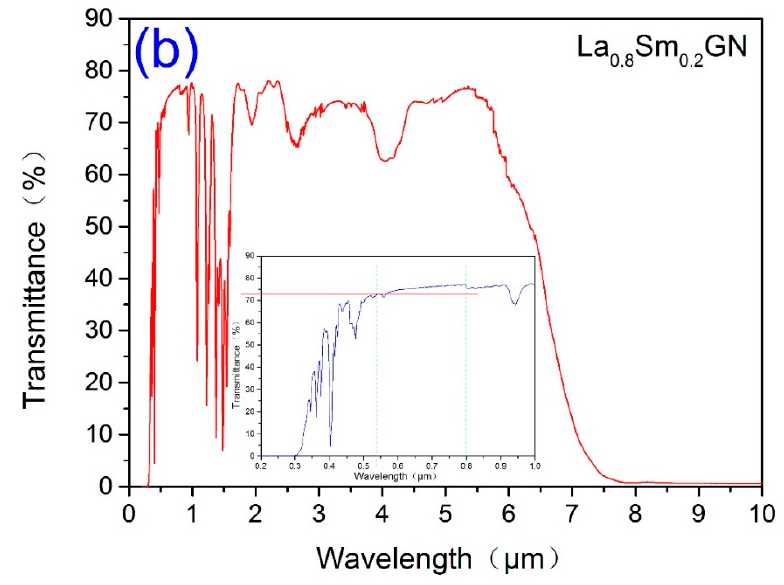
Figure 4. The transmission spectra of Sm:LGN crystals: ( a ) La 0.9 Sm 0.1 GN and ( b ) La 0.8 Sm 0.2 GN.